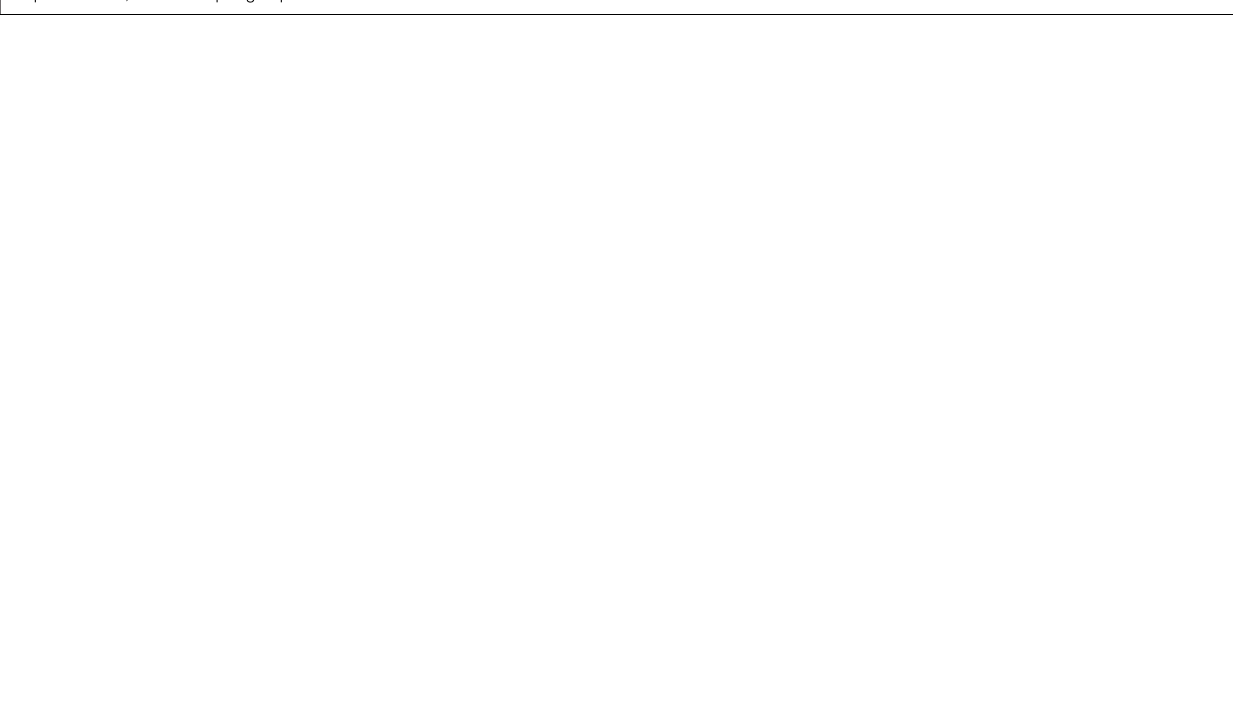
FIGURE 6 | DEN treatment induced a signi fi cant upregulation of phospho-EGFR, phospho-H3, and PKM2 nuclear accumulation in rat livers. (A) Top, representative photos of livers from normal and DEN-treated rats; bottom, representative images of H&E-stained livers. (B) The phosphorylational level of EGFR at Tyr 1068 was increased in the livers of DEN-treated rats. ** p < 0.01, two-tailed unpaired t-test, n (cid:1) 8 rats per group. (C) The expression of PKM2 nuclear protein was upregulated inthe livers ofDEN-treatedrats. Lamin B1was used asan internal control, and β -actin was used asa negative control. ** p < 0.01, two-tailed unpaired t -test, n (cid:1) 8ratspergroup. (D) ThephosphorylationallevelofH3-Thr 11 wasincreasedintheliversofDEN-treatedrats.** p < 0.01,two-tailedunpaired t -test, n (cid:1) 8ratsper group. (E,F) Theexpression ofPD-L1 mRNA (E) and protein (F) wasincreasedintheliversofDEN-treatedrats.** p < 0.01, *** p < 0.001,two-tailedunpairedt-test, n (cid:1) 8 rats per group. (G) ChIP analyses showed that DEN administration resulted in enhanced H3-Thr 11 phosphorylation at the PD-L1 promoter in rats. ** p < 0.01, two-tailed unpaired t -test, n (cid:1) 8 rats per